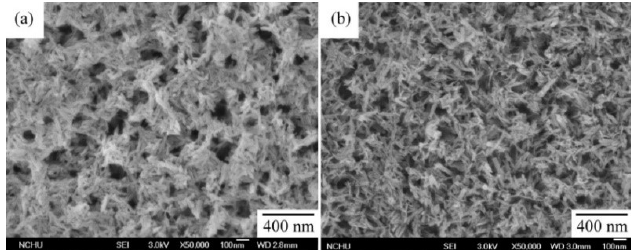
Figure 2. FE-SEM photographs of HA-coated c.p. Ti samples after hydrothermal treatment at 150 °C for 48 h: non-heat-treated surface ( a ) and heat-treated surface at 500 °C for 2 h ( b ).